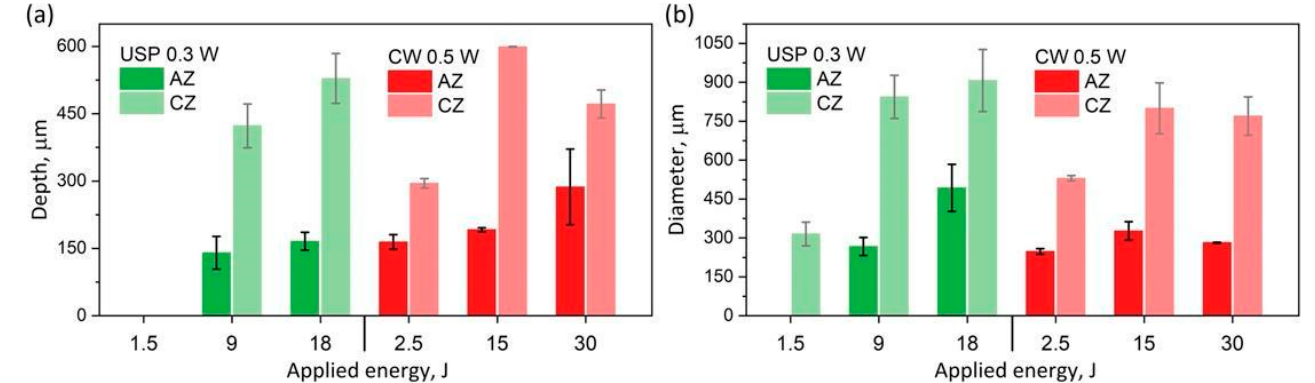
Figure 6. Dependence of ( a ) diameter and ( b ) depth for ablation (AZ) and coagulation (CZ) zones on the applied energy of USP and CW radiation at exposure times of 5, 30 and 60 s.